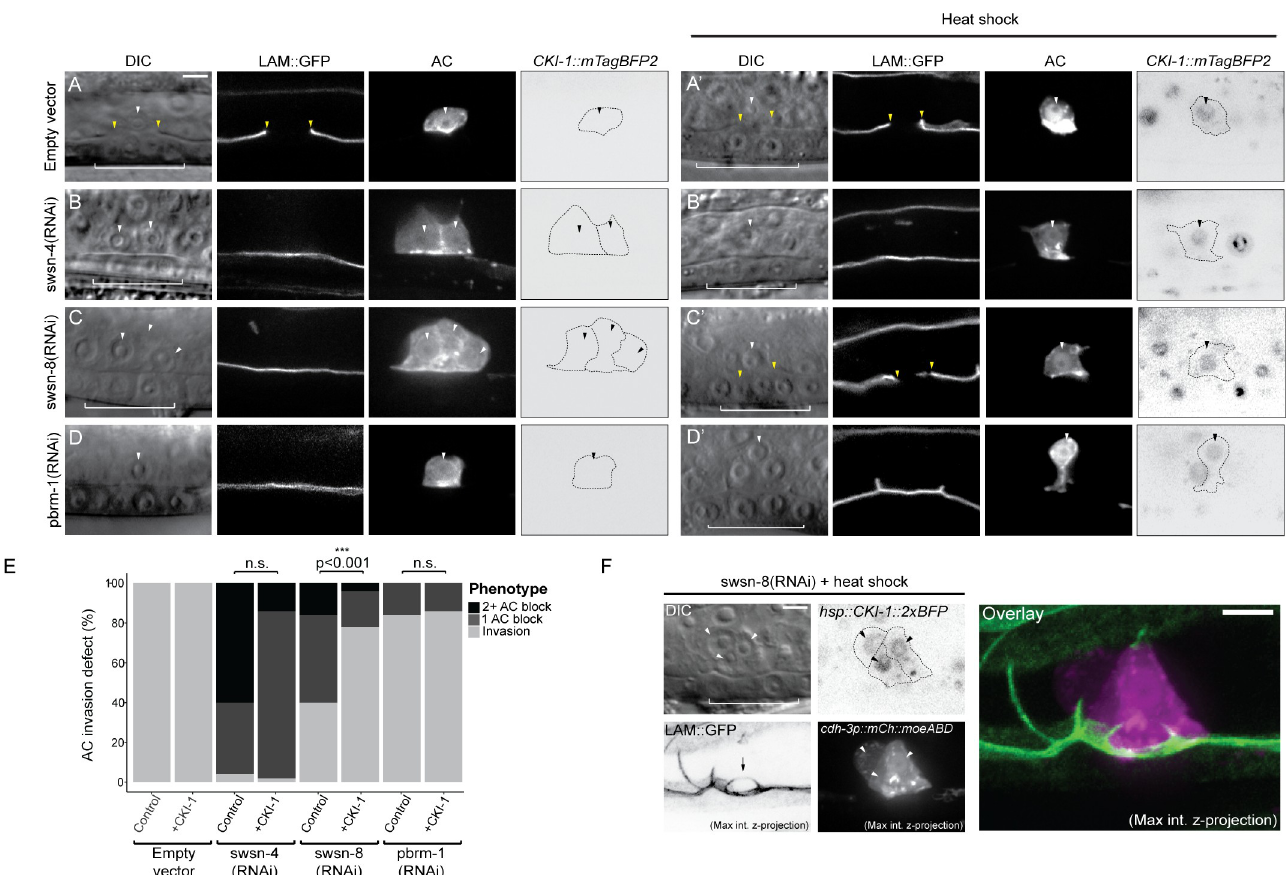
Fig 6. BAF depletion is rescued by G 0 arrest. Representative micrographs depicting DIC (left), BM ( laminin :: GFP , center-left), AC ( cdh-3p :: mCherry :: moeABD , center-right), and CKI-1 ( hsp :: CKI-1 :: mTagBFP2 )expression in empty vector control (A-A’) and treatment with SWI/SNF RNAi under standard conditions (A-D) and following heat shock induction of CKI-1 (A’-D’) . CKI-1 images have been inverted for ease of visualization. White arrowheads indicate AC(s), yellow arrowheads indicate boundaries of breach in BM, and white brackets indicate 1˚ VPCs. Black dotted lines in CKI-1 ::mTagBFP2 panels delineate the boundaries of ACs; black arrowheads indicate position of nuclei in ACsScale bar, 5 μ m. (E) Stacked bar chart showing percentage of AC invasion defects corresponding to each RNAi treatment under standard growth conditions (control) and following heat shock induction of CKI-1 (+CKI-1), binned by AC phenotype (n � 30 animals per condition; Fisher’s exact test compared CKI-1(+) animals with control, non-heat shocked animals; p value is displayed above compared groups). n.s. not significant. (F) Representative micrographs of invasive group of swsn-8 deficient ACs following induction of G 0 /G 1 arrest. DIC (top-left), BM (bottom-left), CKI-1 expression (top-right), AC reporter (bottom-right). Max intensity z-projection of AC and BM reporter channels (right). Large breach in BM is indicated by black arrow in the bottom left panel. Scale bar, 5 μ m.